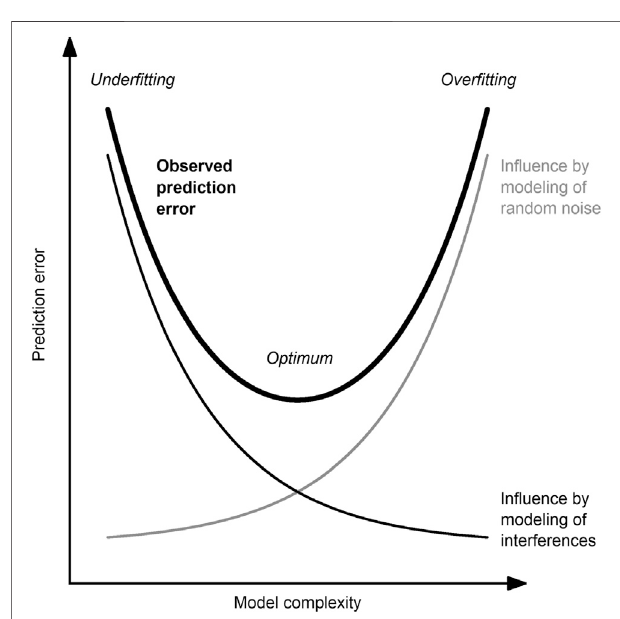
FIGURE 2 | Between the poles of under fi tting and over fi tting. The observed error (thick, black line) of a predictive model is in fl uenced by the modelingofrandomnoise(undesired;thin,grayline)andinterference(desired; thin, black line). The optimal model complexity is a trade-off between these two competing effects and is